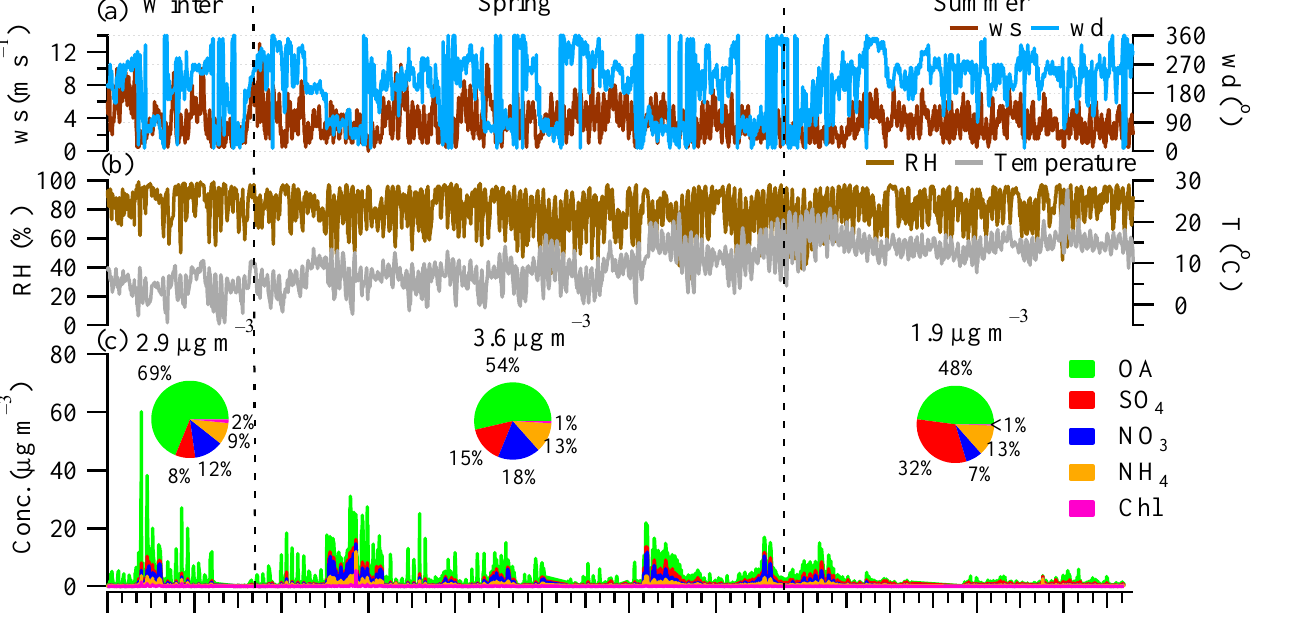
Figure 1. Time series of ( a ) wind speed (ws) and wind direction (wd); ( b ) relative humidity (RH) and Temperature (T); and ( c ) the major NR-PM 1 species, i.e., organics (OA), sulfate (SO 4 ), nitrate (NO 3 ), ammonium (NH 4 ), and chloride (Chl) from 5 February 2016 to 31 July 2016. The sampling period covered the season of winter (February), spring (March, April, and May), and summer (June and July). Inset pie charts show the relative contribution of different NRPM 1 species, with values above showing the average concentration over different